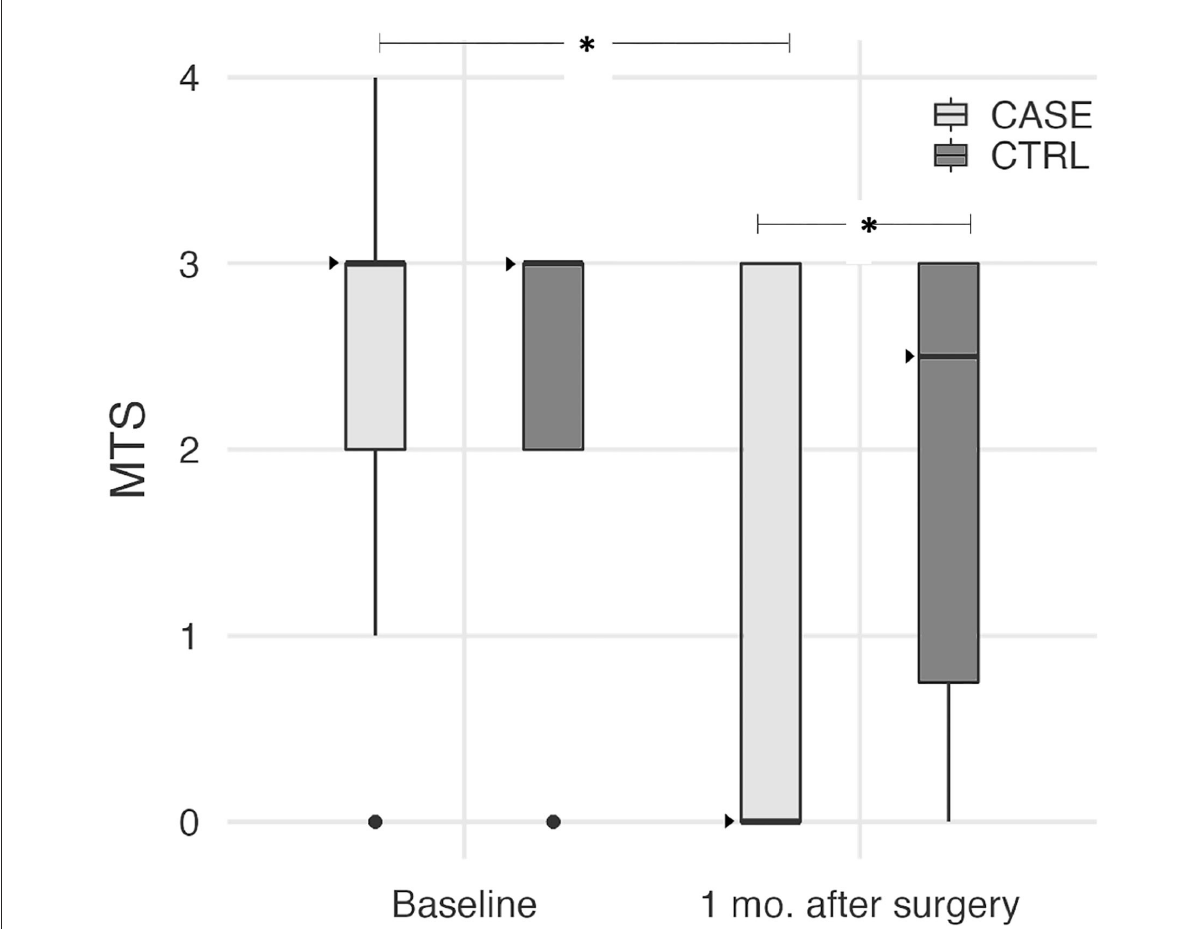
FIGURE1 Boxplot diagrams of the MTS score at baseline and 1 month after surgery in both CASEs and CTRLs. Median values are shown as dark triangles. MTS significantly decreased in the CASE group only (Wilcoxon test, p < 0.001), with the median score reduced from 3 to 0. After surgery, MTS became significantly lower in CASEs compared to CTRLs (Mann-Whitney test, p = 0.033). Asterisks indicate these statistically significant